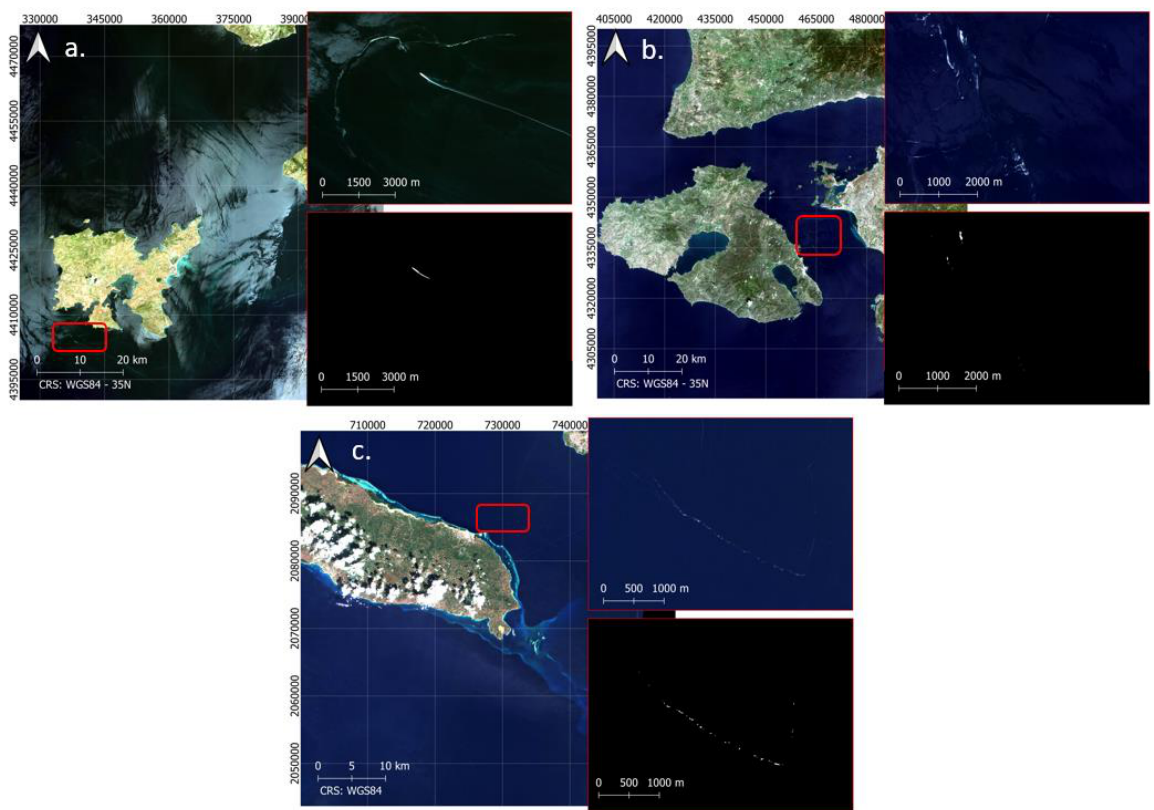
Figure 11. Partial unmixing results showing larger study area, close-up of the surface accumulations and the detected pixels after the applied partial unmixing: ( a ) sea snot accumulations off Lemnos Island, ( b ) pollen off Lesvos Island and ( c ) reported marine debris accumulations off La Gonave Island in Haiti [23].